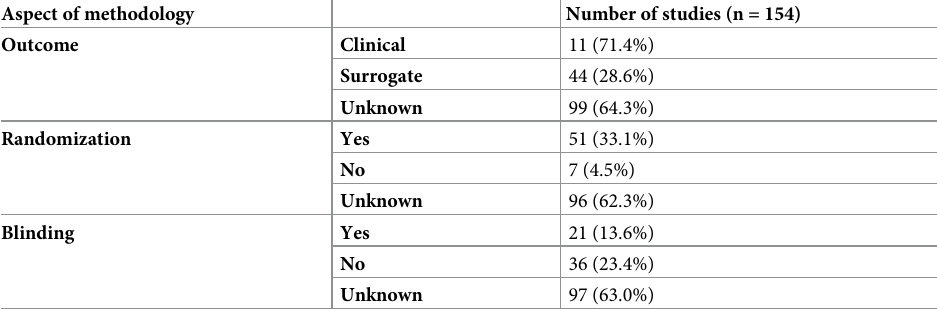
Table 2. Distribution of individual studies by outcome, randomization and